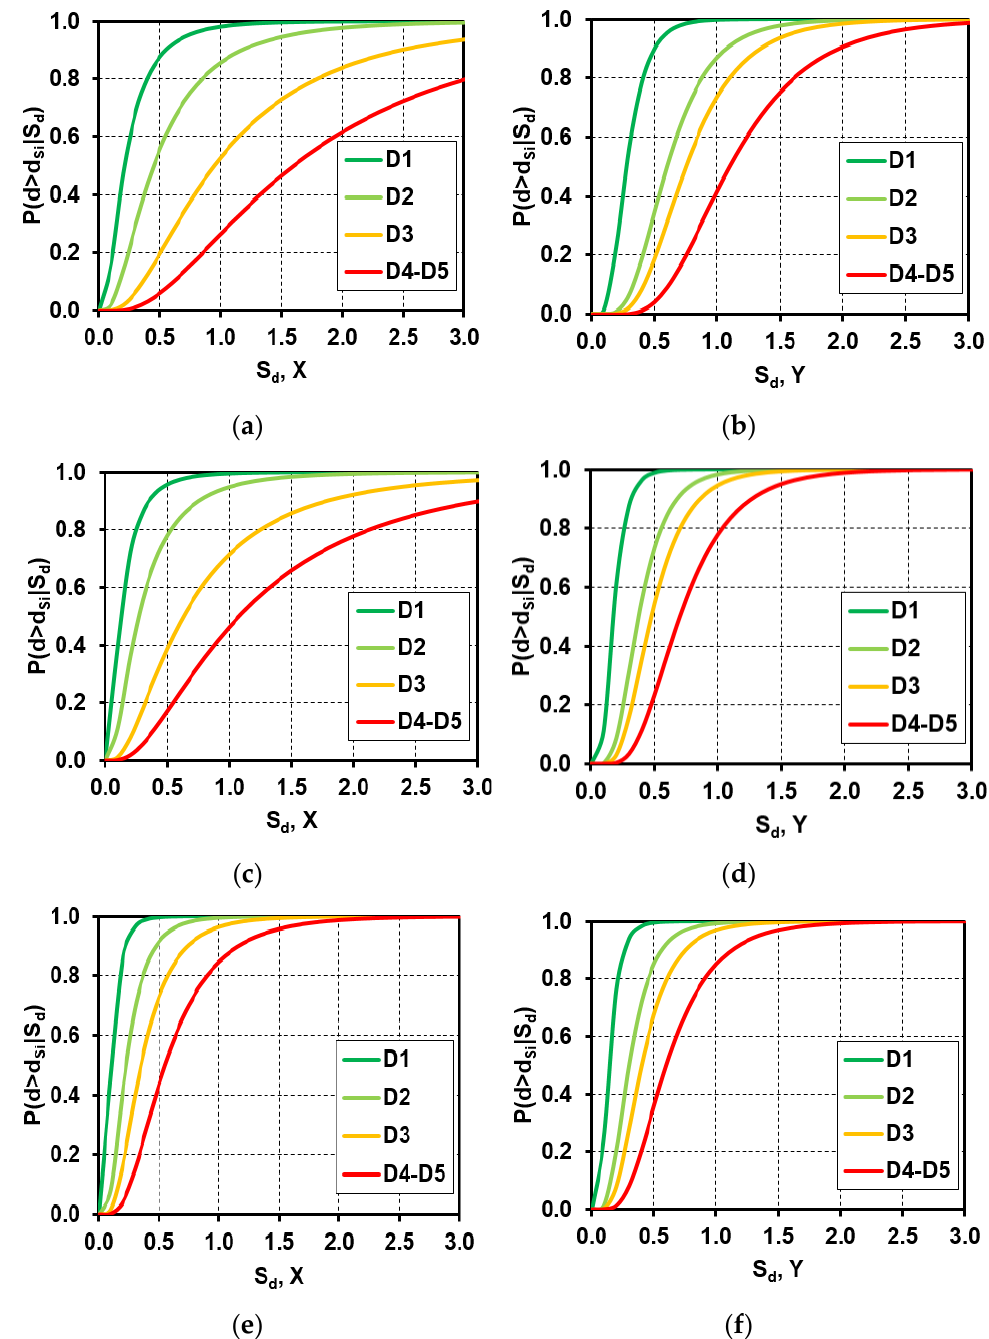
Figure 16. Fragility curves for the examined structural units in X ( a – e ) and Y ( b – f ) directions; ( a ) Head SUs; ( b ) Head SUs; ( c ) Intermediate SUs; ( d ) Intermediate SUs; ( e ) Corner SUs; ( f ) Corner SUs.